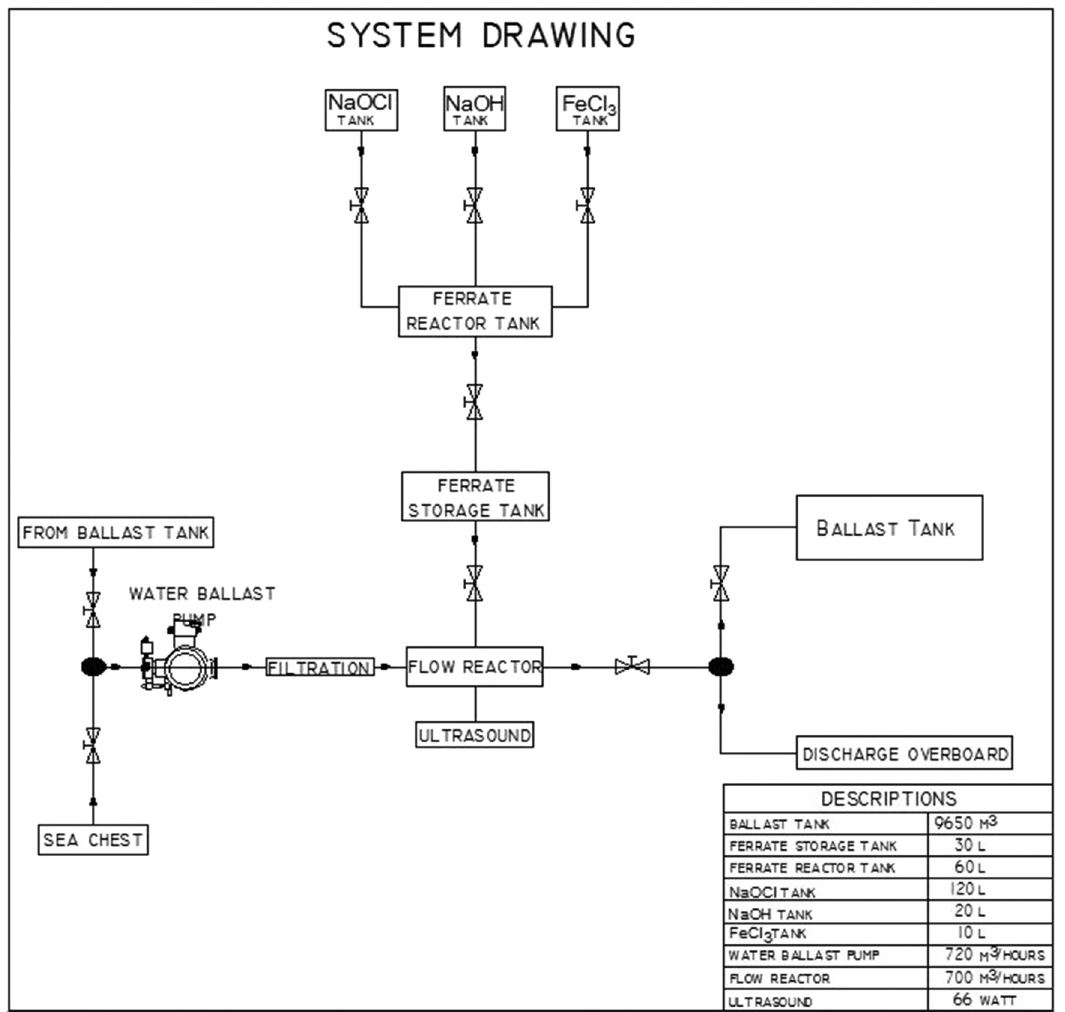
Figure 4: Designed system of the ballast